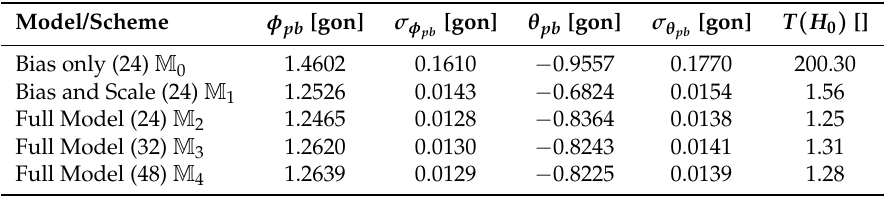
Mounting parameters with corresponding test quantity of adjustments global test. Threshold for H 0 acceptance is about